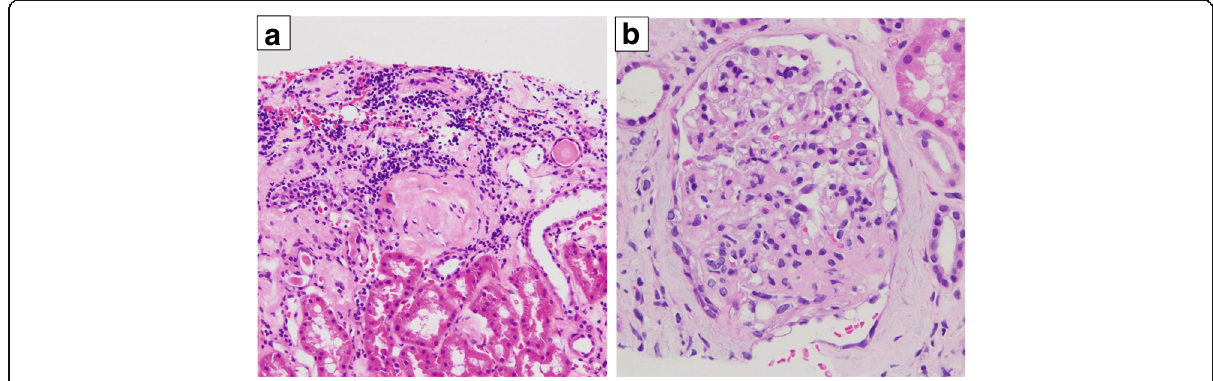
Fig. 6 Light microscopy findings of kidney biopsy. a Light microscopy showed nodular expansion of mesangium and infiltration of lymphocytes into the interstitium (HE, ×100). b Light microscopy of glomeruli showed increased mesangial matrix and increased mesangial cellularity (HE,